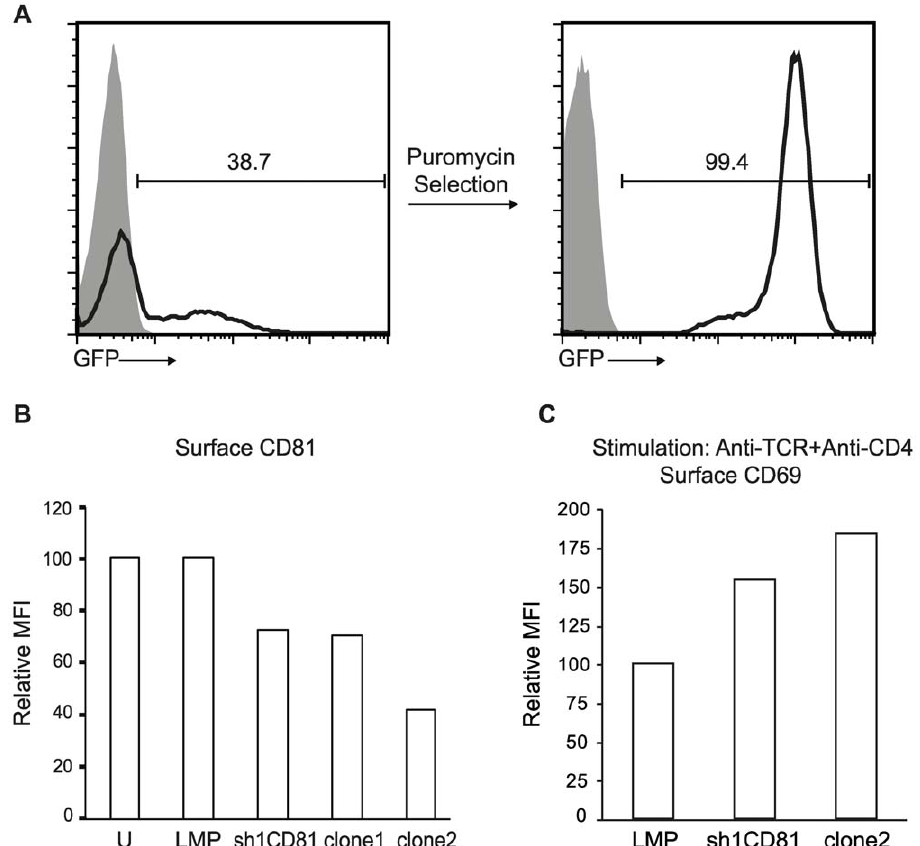
Figure 3. Stable expression of sh1CD81 downregulates surface CD81 expression and increases TCR mediated activation. ( a ) GFP expression before and after puromycin selection in VL3.3M2 cell lines transfected with pLMP encoding CD81 shRNA (sh1CD81) shows the percentage of cells expressing CD81 shRNA. Shaded histograms show fluorescensce of untransfected VL3.3M2 cells and black lined histograms show GFP expression in transfected and antibiotic selected cells. ( b ) CD81 shRNAs decrease surface CD81 expression in stably transfected VL3.3M2 cells. Relative MFI of CD81 expression on the surface of VL3.3M2 cells that are untransfected (U), or stably transfected with empty pLMP constructs (LMP) or with pLMP-sh1CD81 constructs (sh1CD81) or single cell cloned stable sh1CD81 expressing clones (clone1 and clone2) was determined by flow cytometry and plotted as bar graphs. Surface CD81 expression of untransfected VL3.3M2 cells was set to 100. ( c ) Relative MFI of surface CD69 expression on VL3.3M2 cells stimulated with plate bound anti-TCRß (1 m g) and anti-CD4 (1 m g). Surface CD69 expression of empty pLMP transfected VL3.3M2 cells was set to 100.